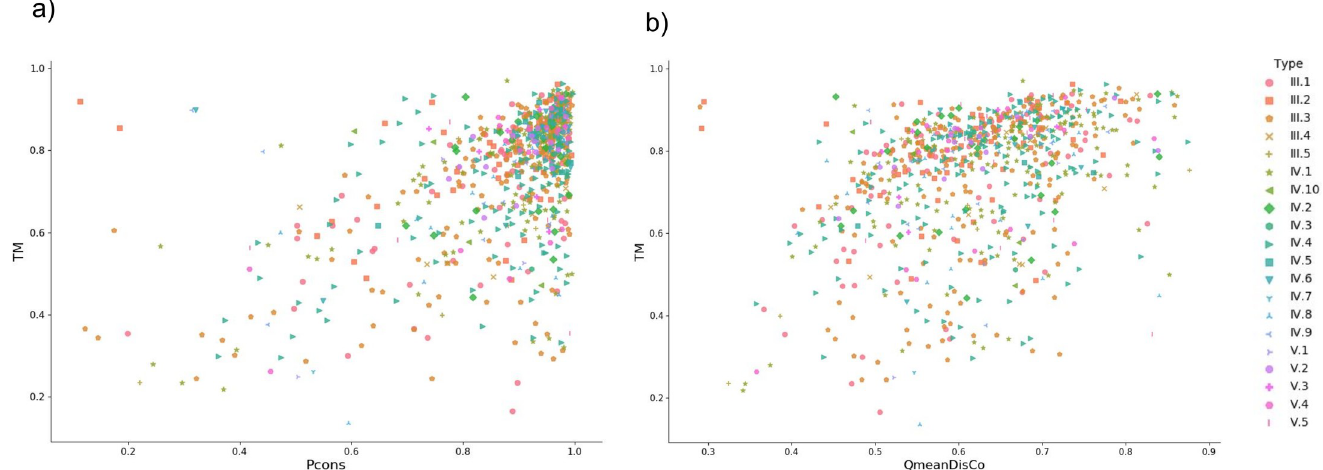
Fig 8. TM-score versus QA methods. a) TM-score versus Pcons-score for complete region models generated with trRosetta. b) TM-score versus QmeanDisCo score for full region models created from trRosetta contacts.